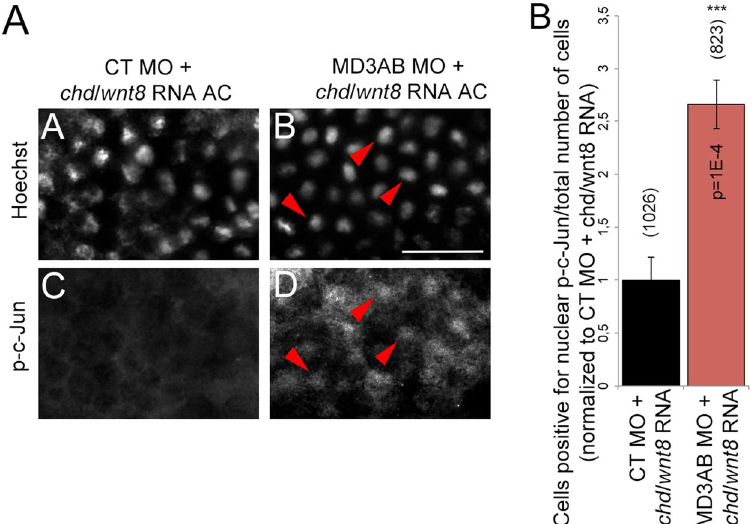
Figure 8. MarvelD3 depletion activates JNK signalling. Analysis of JNK signalling by immunofluorescence using an antibody against phosphorylated form of c-Jun (p-c-Jun) in animal caps injected with chd mRNA + wnt8 mRNA + control morpholino ( A , C ) or chd mRNA + wnt8 mRNA + MD3AB morpholinos ( B , D ). Nuclei were stained with Hoechst; red arrowheads: examples of nuclear co-localization between Hoechst and p-c-Jun staining; scale bar, 50 μ m. ( E ) Quantification of the number of cells with a positive nuclear p-c-Jun staining / total number of cells. Mann-Whitney test p values and the total of cells counted (number in brackets) are indicated on the graph; the values are normalized to control morpholino + chd mRNA + wnt8 mRNA; black bar, chd mRNA + wnt8 mRNA + control morpholino; red bar, chd mRNA + wnt8 mRNA + MD3AB